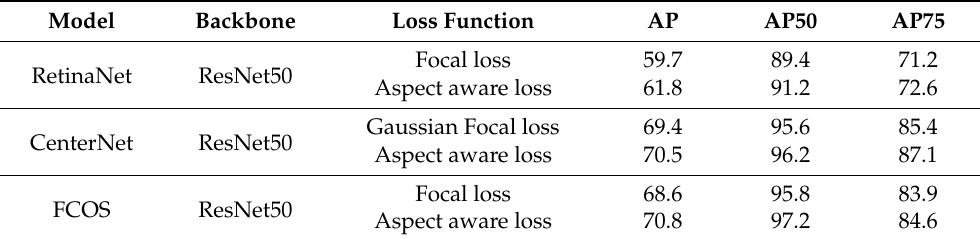
Table 3. Detection results of different models with different loss functions on BCTSDB. Model